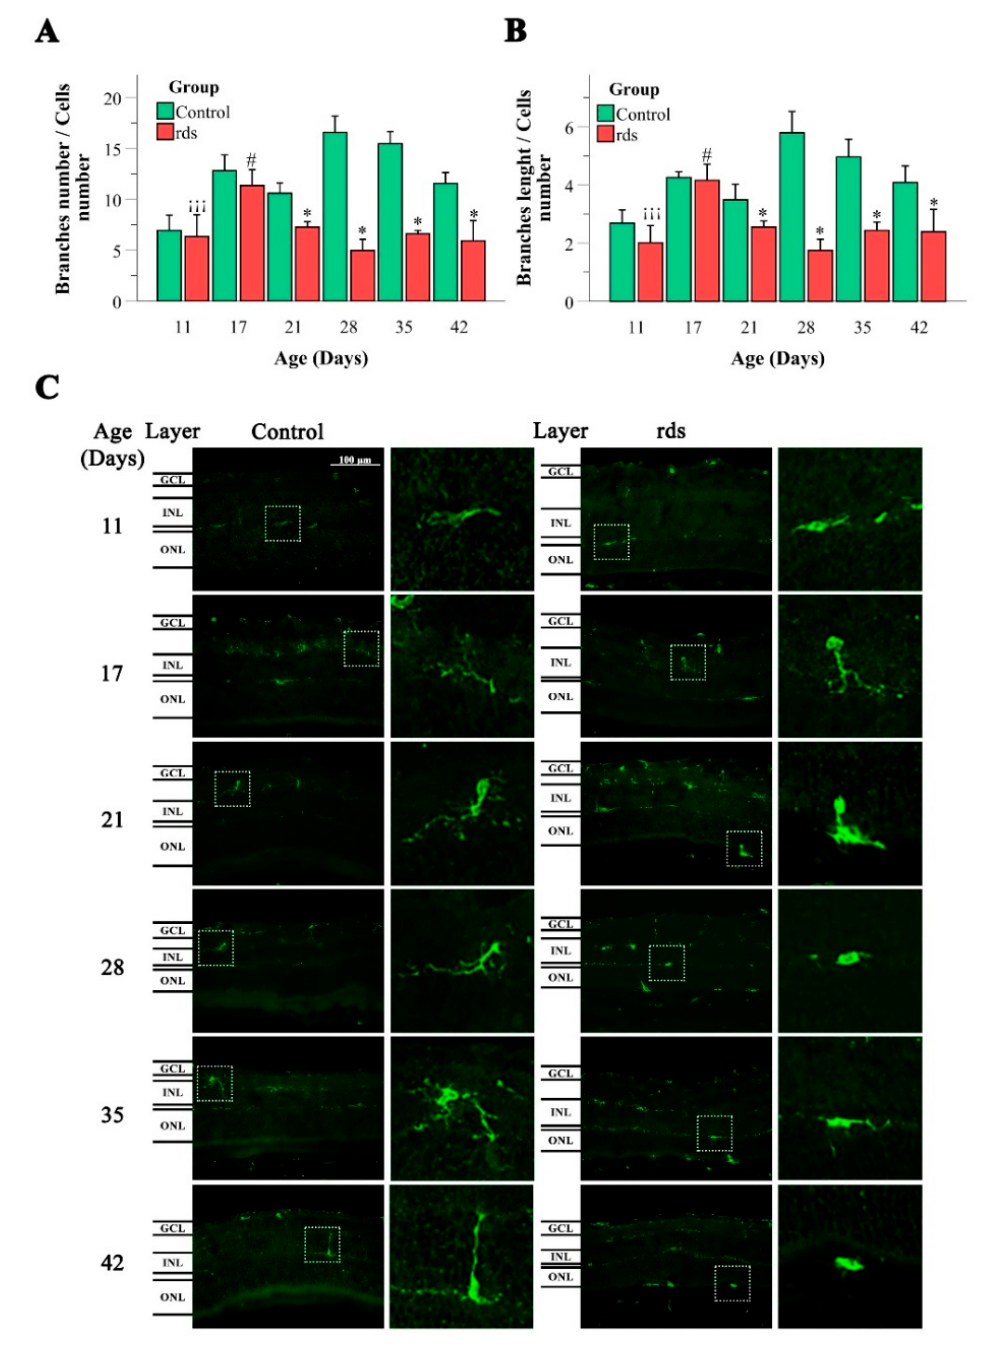
Figure 10. Microglia morphologic analysis. ( A ) Number of branches/Iba1-positive cells in the retinas of control and rds mice at PN11, PN17, PN21, PN28, PN35, and PN42. (* p < 0.005 vs. control at the same postnatal age; # p < 0.005 vs. rds PN21, PN28, PN35, and PN42; ¡¡¡ p < 0.0001 vs. rds PN17). ( B ) Branch lengths of the Iba1-positive cells in the retinas of control and rds mice at PN11, PN17, PN21, PN28, PN35, and PN42. (* p < 0.005 vs. control at the same postnatal age; # p < 0.005 vs. rds PN21, PN28, PN35, and PN42; ¡¡¡ p < 0.0001 vs. rds PN17). Four mice per group were used and three histological sections of one retina of each mouse were quantified. ( C ) Representative micrographs of retinal sections immunostained with Iba1 antibody at PN11, PN17, PN21, PN28, PN35, and PN42 (40× magnification) (photographs on the left side correspond to control mice, and photographs on the right side belong to rds mice).